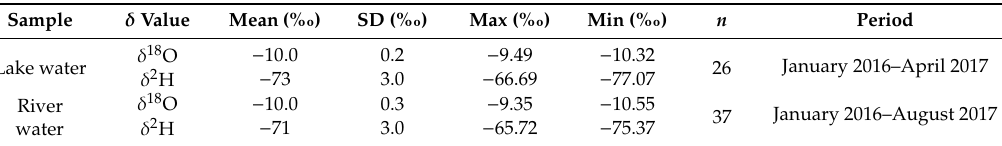
Table 1. Descriptive statistics of isotopes in the lake and river water from 2016 to 2017.